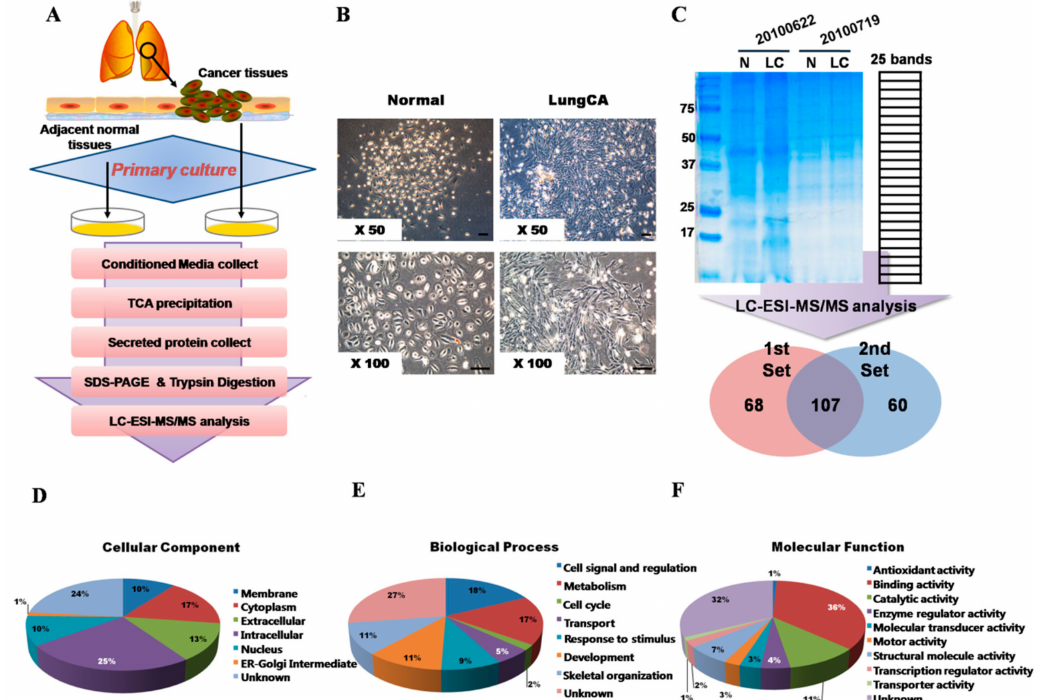
Figure 1. MS/MS analysis of secreted proteins and GO analysis of the identified proteins. ( A ) Schematic diagram of experimental process from primary culture of lung cancer tissues, to secretome enrichment, and LC–MS/MS analysis of secretome. ( B ) Cells isolated by collagenase treatment from the lung cancer tissues and their adjacent corresponding normal tissues. Isolated cells from cancer tissues and corresponding normal tissues show different cellular morphologies. Scale bar, 100 µ m. ( C ) Secreted proteins, enriched by conditioned media, from primary cultured cells of two different lung cancer patients and separated by 1-DE-SDS-PAGE. Separated proteins were divided into 25 bands and subjected to in-gel digestion. Tryptic peptides were subjected to LC–ESI–MS/MS analysis. MS analysis discovered 107 common proteins detected in both MS analytical sets, and 68 were subjected to further GO analysis. ( D ) Identified proteins analyzed by their cellular component, ( E ) biological process, and ( F ) molecular functions. N: normal, LC: lung